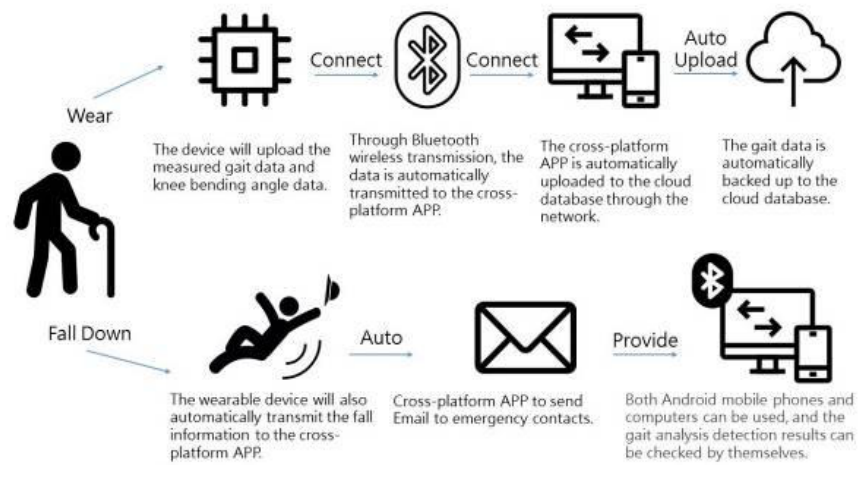
Figure 1. Architecture of CPGAFDWD.